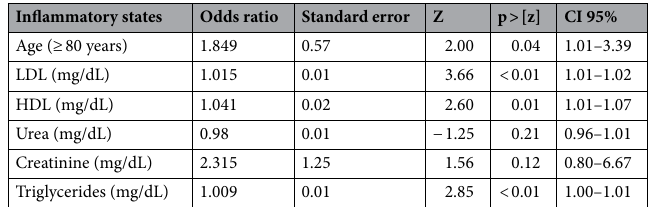
Table 4. Ordinal logistic regression of independent variables in relation to inflammatory states. LDL low density lipoproteins, HDL high density lipoproteins.